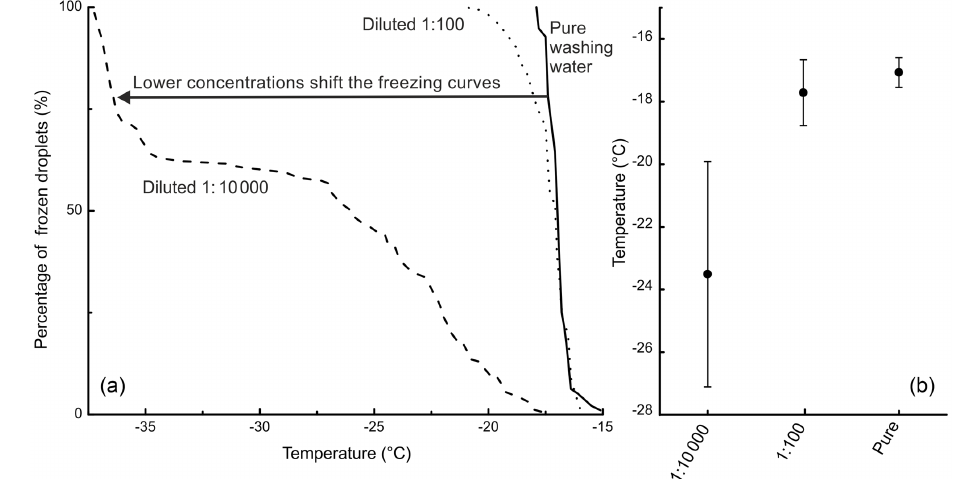
Figure 3. (a) The freezing curves of birch pollen washing water and two dilutions thereof (the dilution 1:100 is equivalent to 10 8 INPmg − 1 ; the dilution 1:10000 is equivalent to 10 6 INPmg − 1 ) with the fraction of frozen droplets as a function of temperature. (b) The MFT with the corresponding standard deviations of the birch pollen washing water and the two analysed